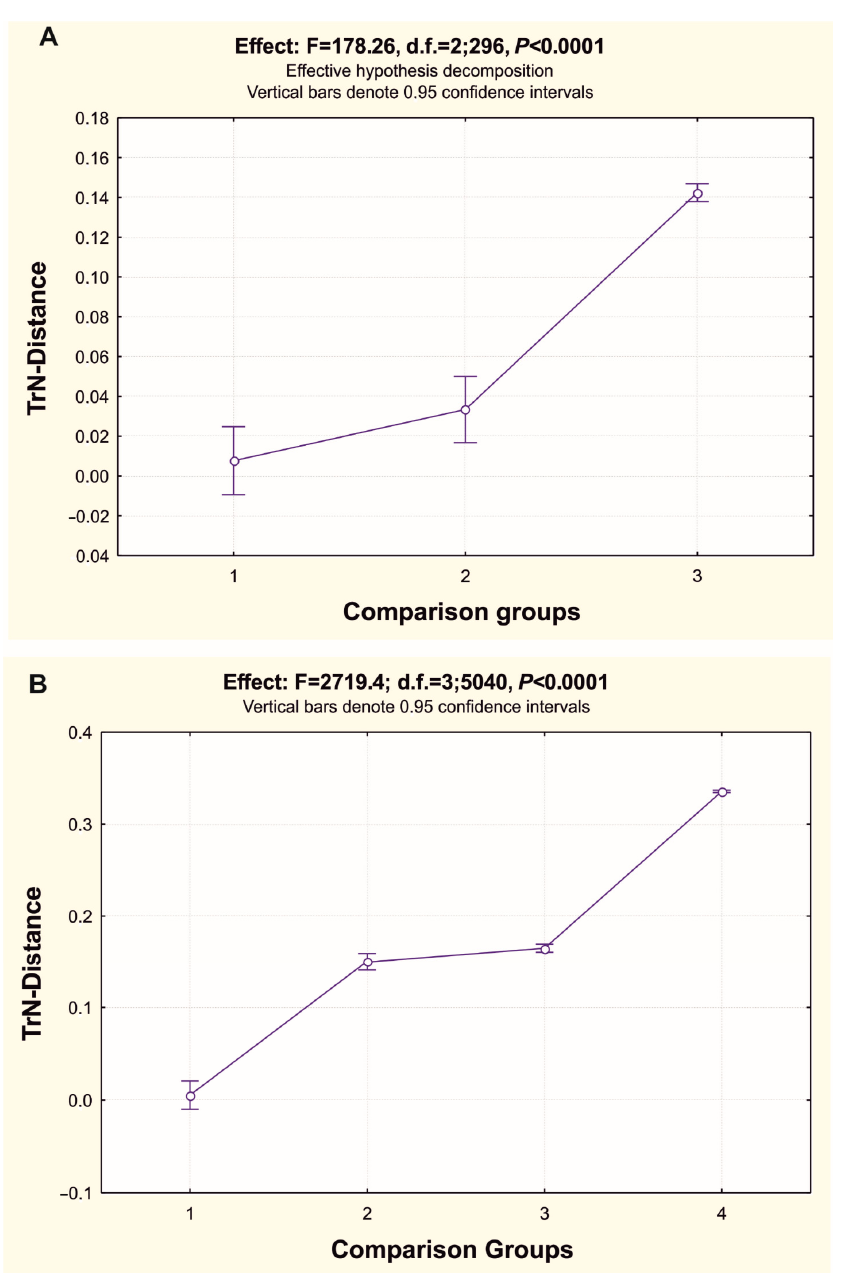
Figure 7. Univariate ANOVA showing the variability of the mean values of genetic distances ( Y axis) for the comparison groups of the sequences in sampled taxa for 13 PCGs of 26 flatfish mitogenomes in Pleuronectidae ( A , top) and 106 flatfish mitogenomes in Pleuronectoidei ( B , bottom). Y axis, Tamura-Nei (TrN) variation in the mean values of distances (in frequencies) among three comparison groups for flatfish: (1) TrN distances within the species, between individuals of the same species; (2) TrN distances within genera, between individuals of different species of the same genus; (3) TrN distances within the family, between species of different genera of the same family, (4) TrN distances within suborder, between individuals of different families of the same suborder. Data on these two analyses were obtained on the sequences of the complete mitogenome of flatfish from GenBank in